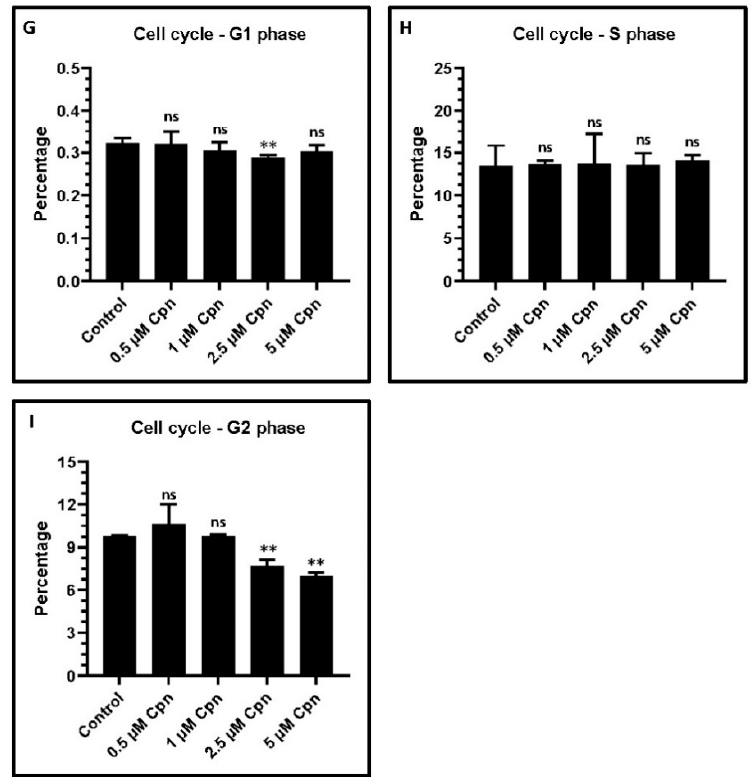
Figure 3. Cell cycle analysis of DPSCs treated with various concentrations of Cordycepin (0.5 µM, 1 µM, 2.5 µM, and 5 µM). ( A – F ) Cell cycle analysis. ( G ) Comparative analysis of G1 phase cells. ( H ) Comparative analysis of G2 phase cells. ( I ) Comparative analysis of S phase cells. ns not significant, ** p < 0.01. Cpn: Cordycepin.